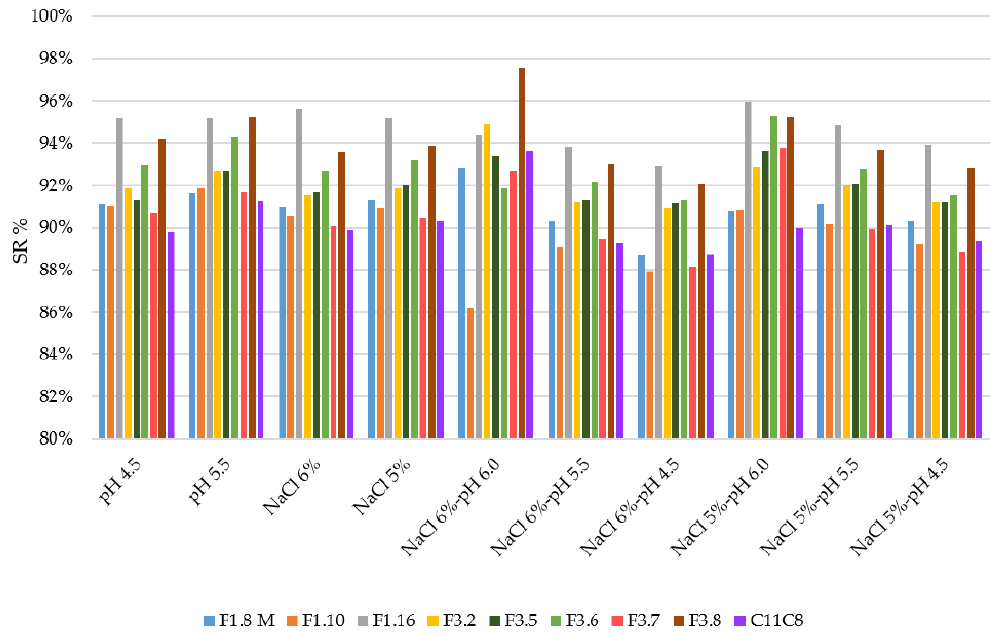
Figure 1. Survival rate plot of the strains, expressed in percentage, under single and combined stress conditions at 32 °C.